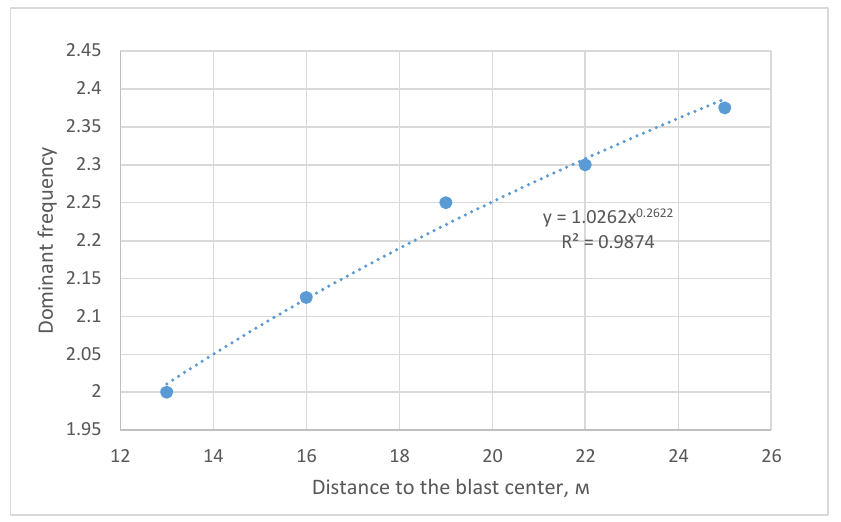
Figure 5. Dominant frequency dependence on the distance. The dependence of the amplitude on the distance is described in Figure 6.